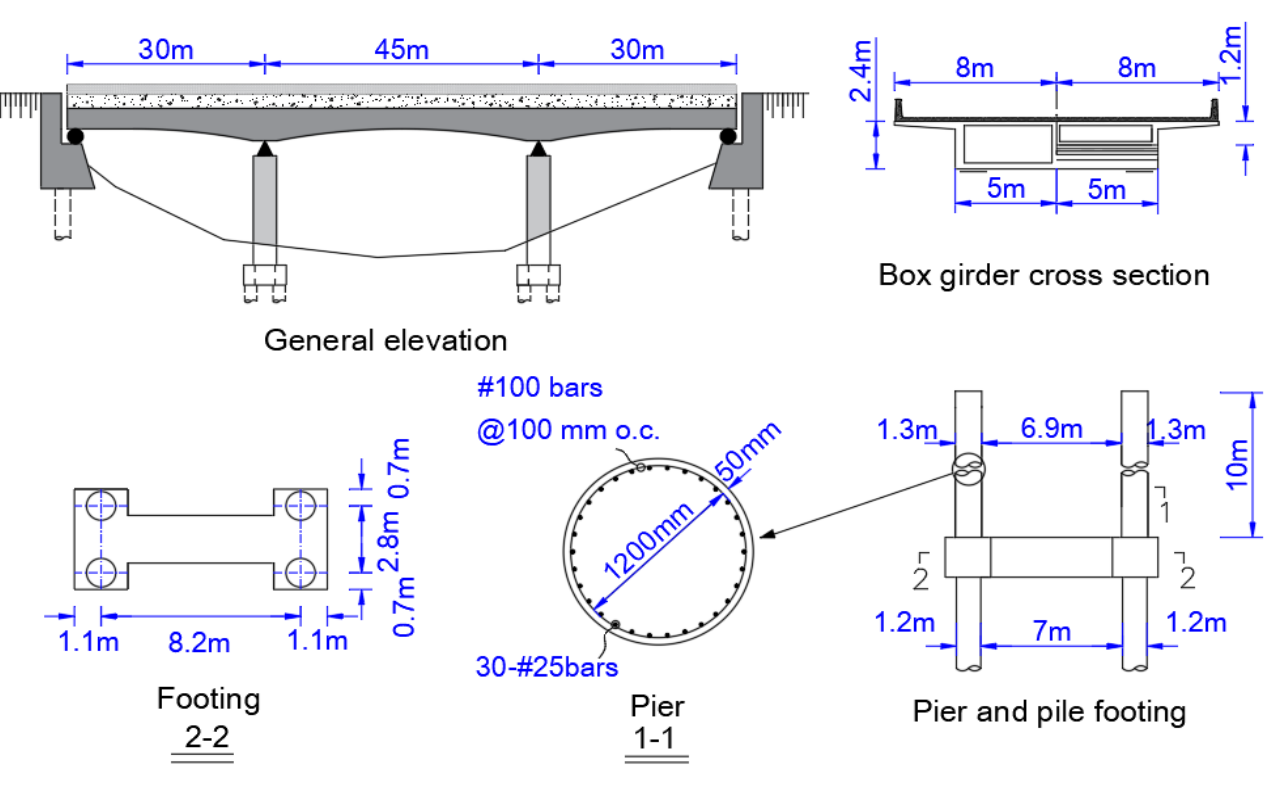
Figure 4. The schematic details of the bridge.